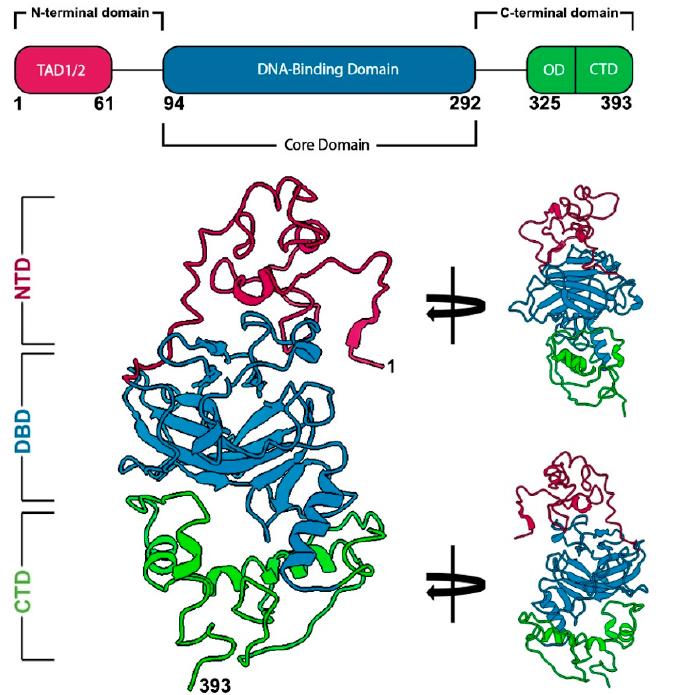
Figure 1. Primary sequence and structural domains of the p53 monomer. The p53 primary structure (residues 1-393) is comprised of the N-terminal domain (NTD) that contains transactivation do- mains (TAD 1/2), followed by the DNA-binding domain (DBD), and the C-terminal domain (CTD). Prior to the C-terminus is the oligomerization domain (OD) (top panel). The full-length p53 mono- mer structure was recently determined using cryo-EM and highlights each of these important re- gions (bottom panel, Movie S1) (pdb code, 8F2I) [22]. Length of the p53 monomer is ~60